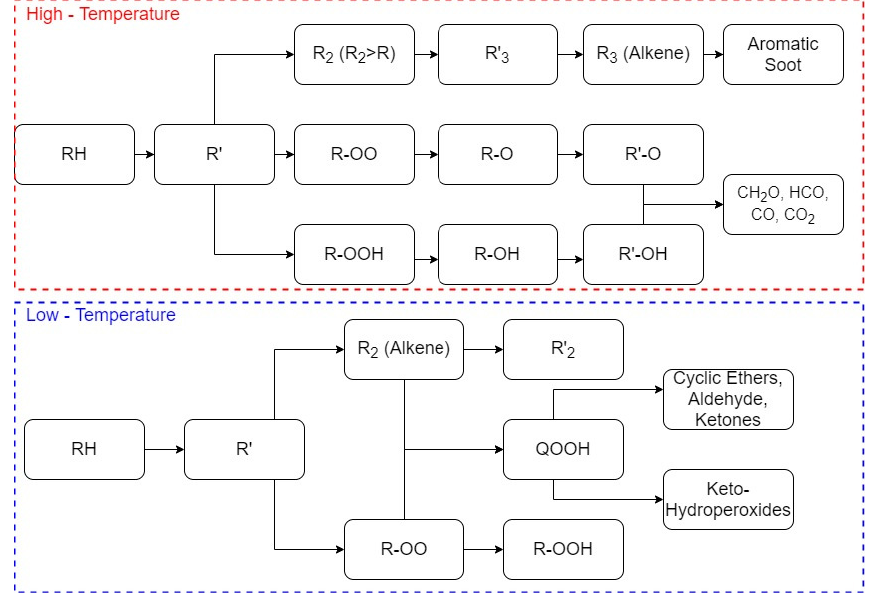
Figure 1. Simplified representation of the ruling kinetic mechanisms at high ( top ) and low ( bottom ) temperatures.